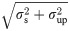
Optimal ON-OFF or ON-ON nonlinearities for slices through parameter space.A: Schematics showing regions of the effective 3-dimensional parameter space: total input correlation ρeff (purple), scaled Poisson strength κ (blue), and downstream noise standard deviation σdown (green). Insets show the optimal nonlinearity corresponding to the like-colored point. Top schematic: optimal ON-OFF nonlinearities, bottom: optimal ON-ON nonlinearities. B: Slopes of the optimal nonlinearities (rescaled by σs2+σup2) for ON-OFF (solid) and ON-ON (dashed) solutions as each parameter is varied along the corresponding dashed axis in A. C: Offsets (rescaled by 1/σs2+σup2) plotted in the same manner as B. Insets in the ρeff plots are zoomed in to resolve the splitting of the identical ON-ON solution into the non-identical ON-ON solution. Rescaled slopes and offsets are obtained from numerical solutions of the analytic model; see Methods for details about rescaling.